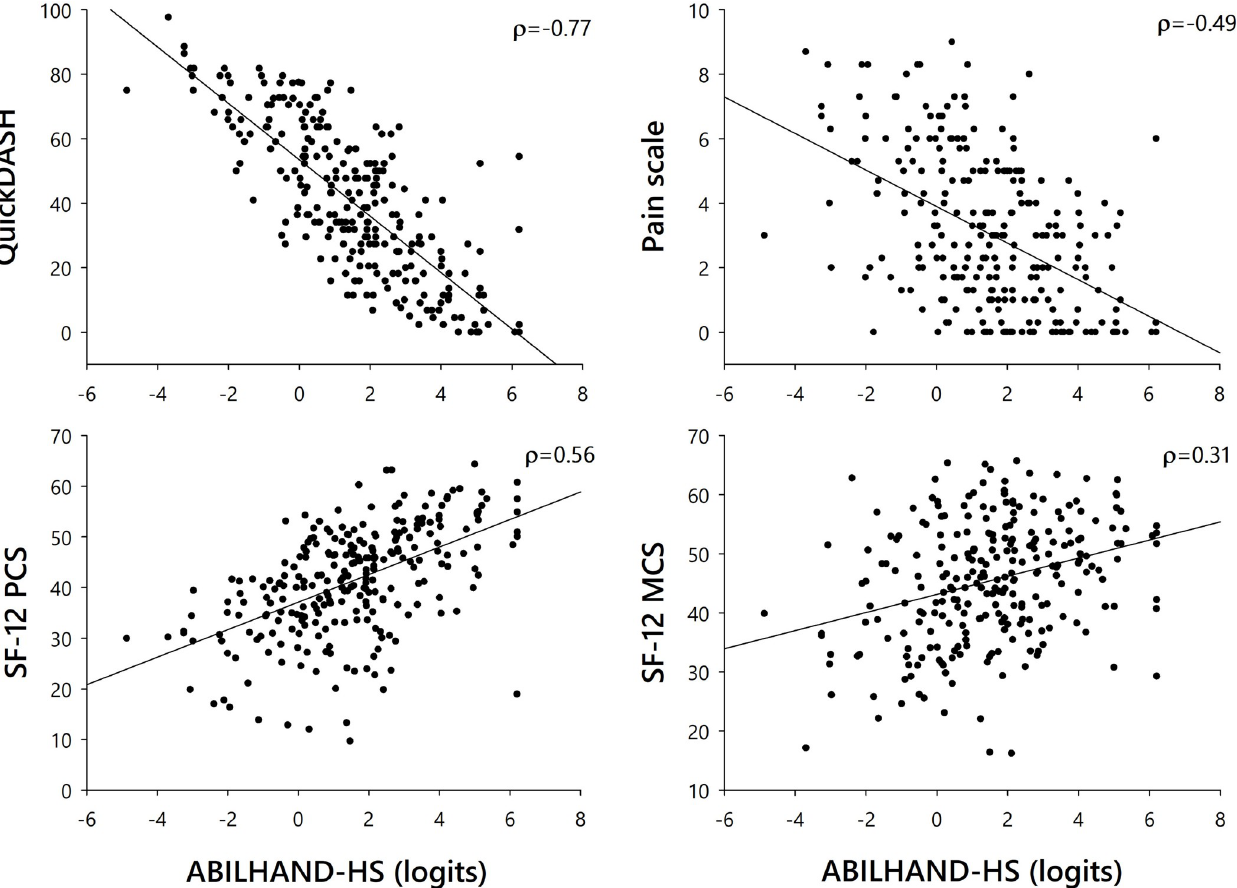
Fig 3. Correlations of ABILHAND-HS scores with QuickDASH, PCS, MCS, and numerical pain scale scores. Spearman correlation coefficients are indicated in the top right of each graph. All correlations were statistically significant (p < 0.001).